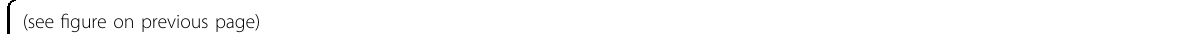
Fig. 2 CXCL4/PF4 protein is associated with transcriptional stem cell quiescence in untreated PV and inhibits the colony-formation capacity of PV HSC/MPPs. A Activity analysis of transcription factors (TFs) regulating CXCL4/PF4 expression showed signi fi cantly downregulated activity for the TF ELF1 and to a lesser degree for the TF USF2 in untreated PV patients compared to controls and HU-treated PV patients. Error bars represent standard errors. * P < 0.05. B Gene set enrichment analysis showed strong and signi fi cant enrichment for genes downregulated in stem cell quiescence in HSC/MPPs of untreated PV patients (PV.UT) compared to HSC/MPPs of controls, suggesting cessation of stem cell quiescence in PV stem cells. C Treatment of patients with hydroxyurea (PV.HU.HSC/MPP versus PV.UT.HSC/MPP) reversed the loss of stem cell quiescence in the PV HSC/MPP subpopulation. NES normalized enrichment score. D Heatmap of RNAs enriched in different patient/control groups for genes downregulated in stem cell quiescence. The corresponding enrichment plots and heatmap for the protein level are shown in Supplementary Fig. 4A- C. E Functional single-cell CXCL4/PF4 assay: colony growth of FACS-sorted HSC/MPPs from untreated chronic PV patients (PVchron.UT) singly incubated in cytokine-enriched serum-free medium was assessed in presence or absence of CXCL4/PF4. Colony growth as depicted was evaluated in 864 wells after 7 days of incubation. In individual patients, signi fi cance was determined using Fisher ’ s exact test; signi fi cance overall was calculated using two-tailed and paired Student ’ s t test (see Supplementary Methods). A strong growth inhibitory role of CXCL4/PF4 was observed. F Methylcellulose colony assay: the growth of different myeloid colony subtypes from FACS-sorted HSC/MPPs of untreated chronic PV patients (PVchron.UT) was evaluated in presence or absence of CXCL4/PF4. Reductions in colony growth due to CXCL4/PF4 protein were observed for all colony subtypes with signi fi cant inhibitions seen in the CFU-GM and BFU-E colony subtypes as well as in composite granulocyte/macrophage (CFU- GM and CFU-G and CFU-M) and erythroid (BFU-E and CFU-E) colonies. Relative numbers of colonies related to the total cell numbers plated are plotted. Error bars represent standard deviations. * P < 0.05. CFU-GEMM (mixed colonies), CFU-GM colony-forming unit – granulocyte/macrophage, CFU-G colony-forming unit – granulocyte, CFU-M colony-forming unit – macrophage, BFU-E burst-forming unit – erythroid, CFU-E colony-forming unit –